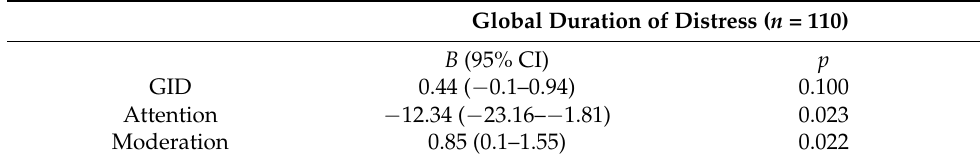
Table 1. Moderation of attention on the global duration of distress.